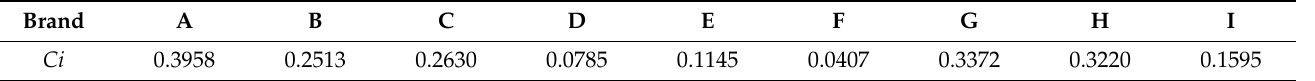
Table 7. The C i